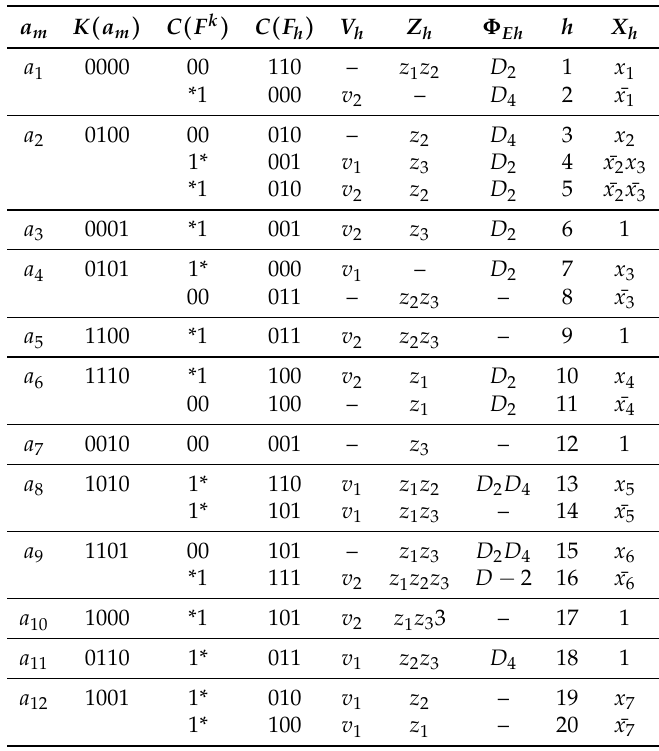
Table 5. Transformed DST of Mealy FSM U 5 ( S 1 )